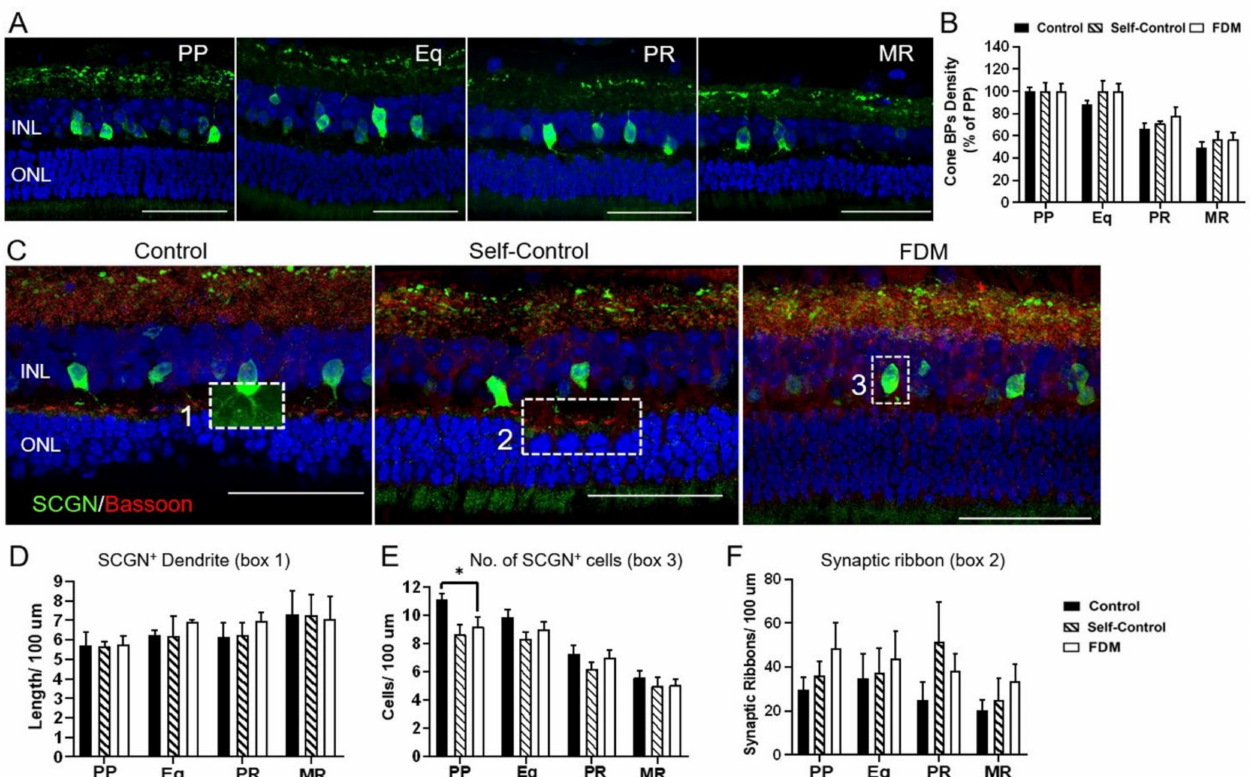
Figure 3. Cone-bipolar cells and synapses in outer plexiform layer. ( A ) Representative confocal images taken from the posterior pole (PP), equator (Eq), peripheral retina (PR) and marginal retina (MR) of naïve control eye staining for secretagogin + (SCGN, green). Nuclei were stained with DAPI (blue). ( B ) SCGN + cone-bipolar cells density expressed as % of PP in different retinal locations in naïve control, self-control and FDM eyes. ( C ) Representative confocal images of bassoon (red) and SCGN (green) labelled retinas from PP of naïve control, self-control and FDM eyes. Box 1 showing cone-bipolar dendrites; box 2 showing bassoon+ synaptic ribbon in the outer plexiform layer, box 3 showing SCGN + cone-bipolar cell body. (D-F) Quantitative data of SCGN + cone-bipolar dendrites ( D ), the number of SCGN + cone-bipolar cells ( E ) and bassoon + synaptic ribbons ( F ) in different retinal locations of naïve control, self-control and FDM eyes. INL, inner nuclear layer; ONL, outer nuclear layer. Scale Bar: 50 µ m. Mean ± SD, n = 3~9/group. * p < 0.05. One-way ANOVA followed by Fisher’s LSD